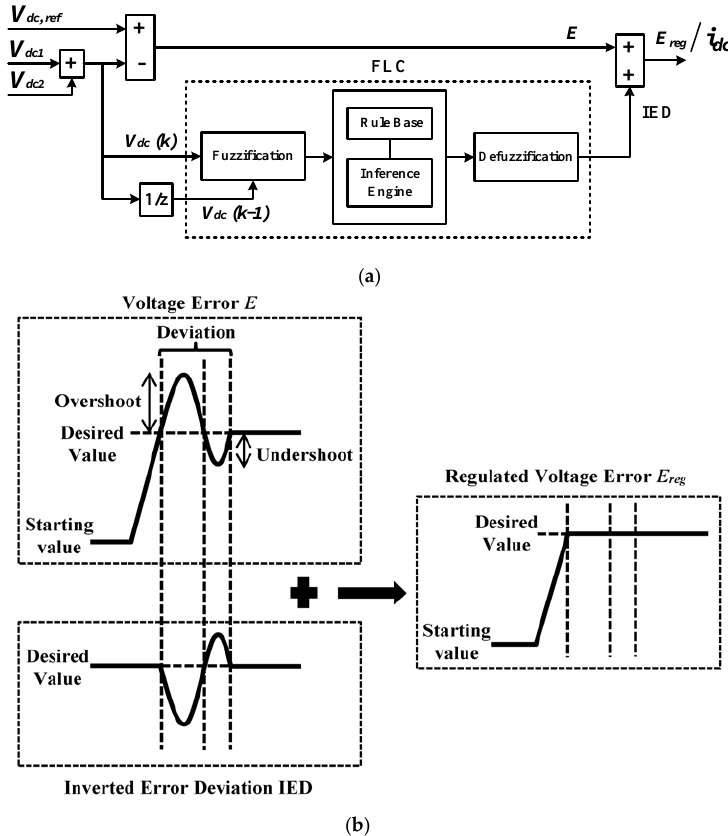
Figure 5. Proposed DC-link capacitor voltage regulation algorithm with IED control: ( a ) control structure; and ( b ) working principle.